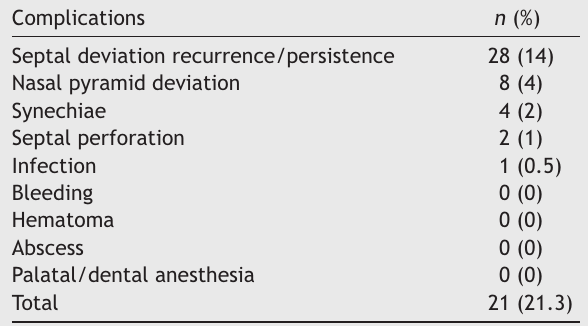
Distribution of identified